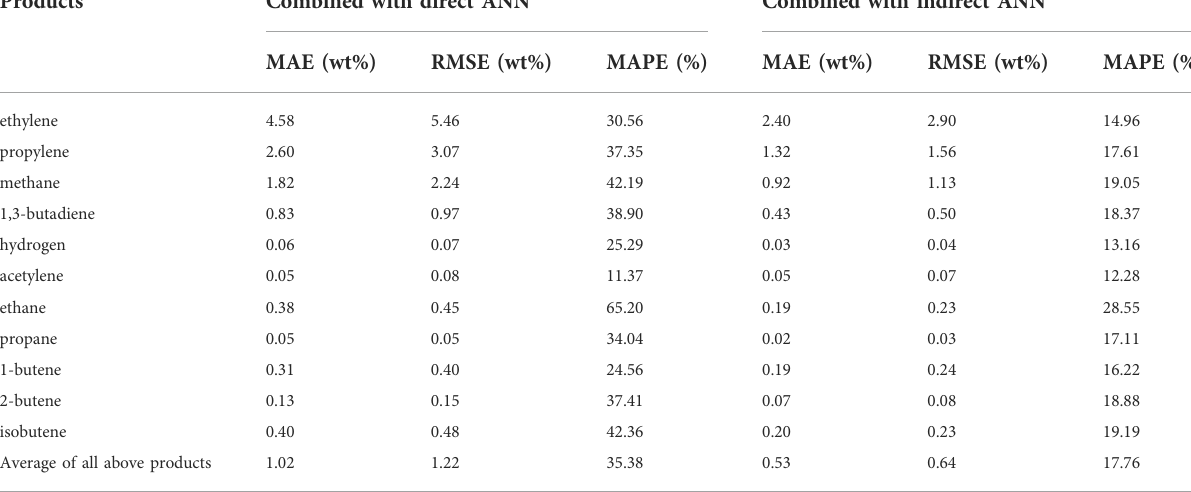
TABLE 5 Statistics for 11 predicted products with the reactor model combined with direct and indirect ANN.